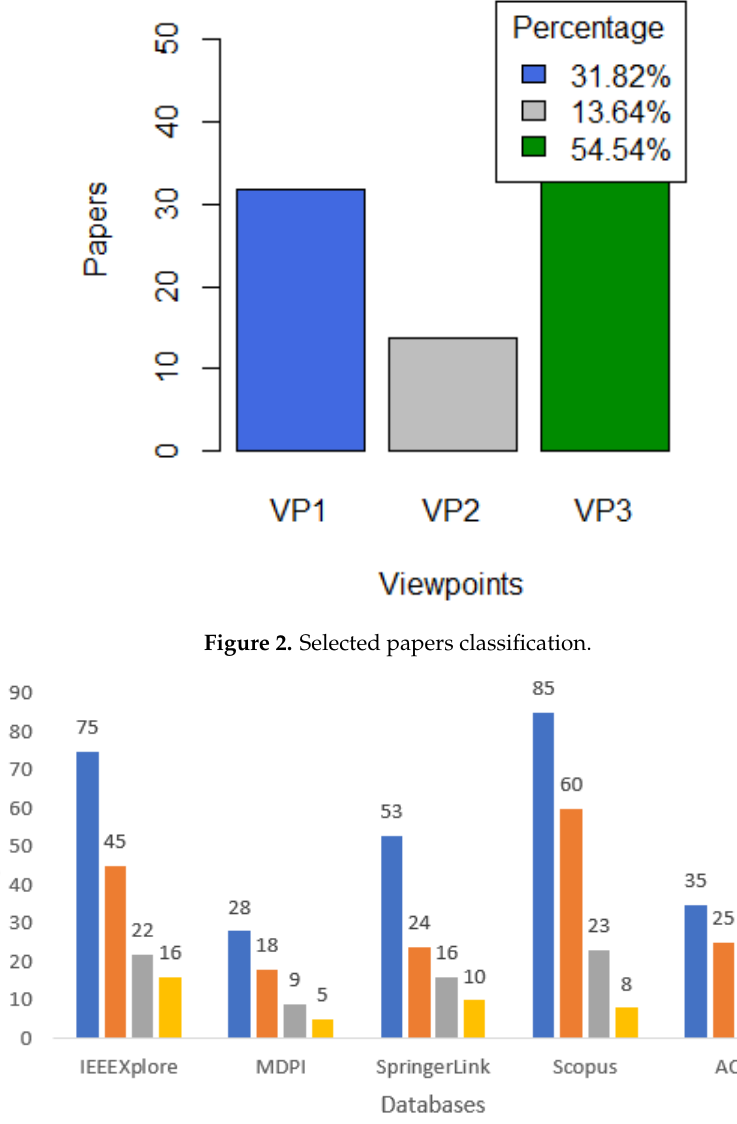
Figure 3. Phases